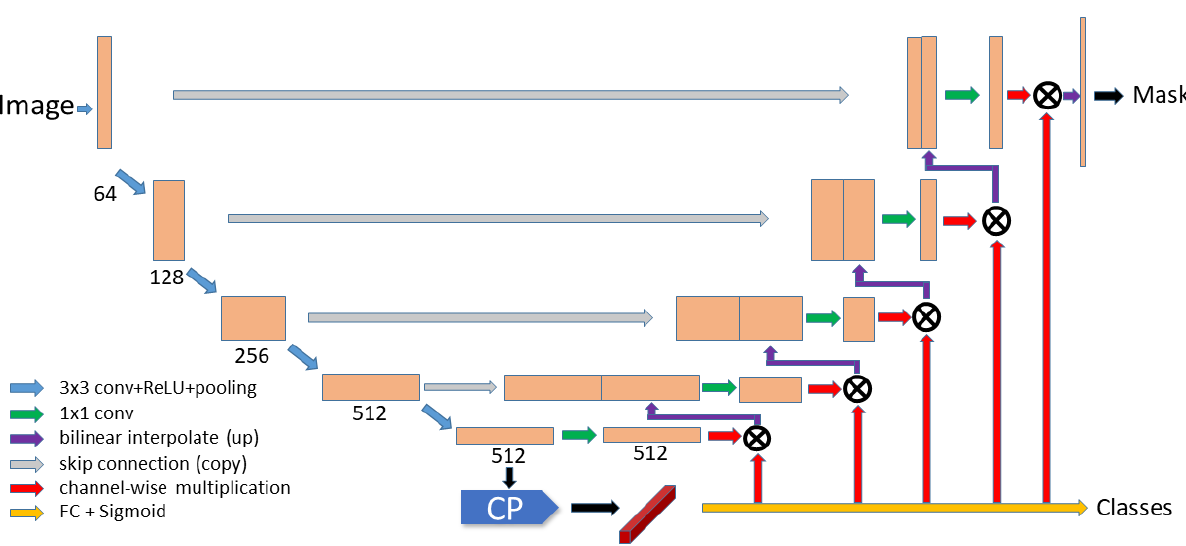
Figure 3. Architecture of the proposed GCANet. The skeleton is a U-shaped architecture similar to the UNet. A multi-class classification branch is added on top of the encoder. The new branch learns linear representation of the input featuremap. Through fully connected layers, the linear representation is, on one way, used to identify classes presented in the input scenes, and is combined with featuremaps of the encoder by channel-wise multiplication on the other way.